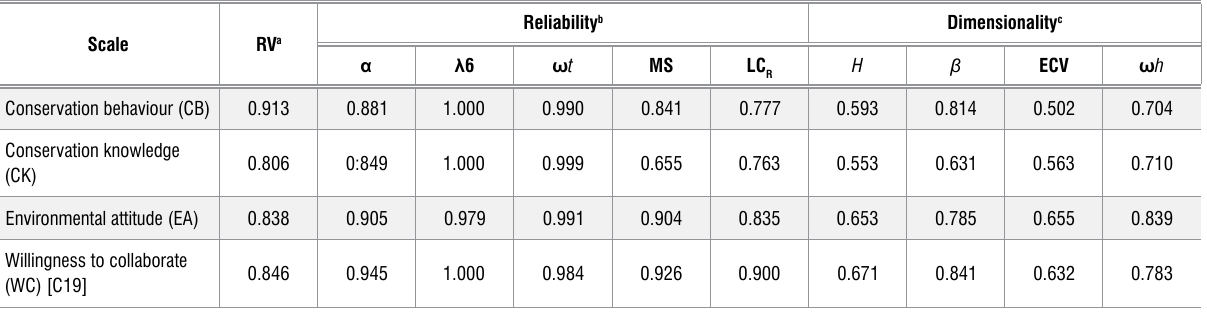
Table 1: Statistics on the reliability and dimensionality of the final scales to measure the four latent variables